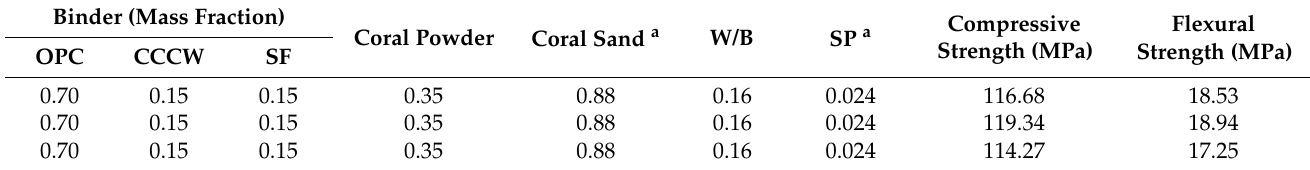
Figure 12. Response surface of the effects of cement, CCCW, and silica fume on the compressive strength: ( a ) contour; ( b ) 3D surface. Table 8. Experimental results of the optimal mix